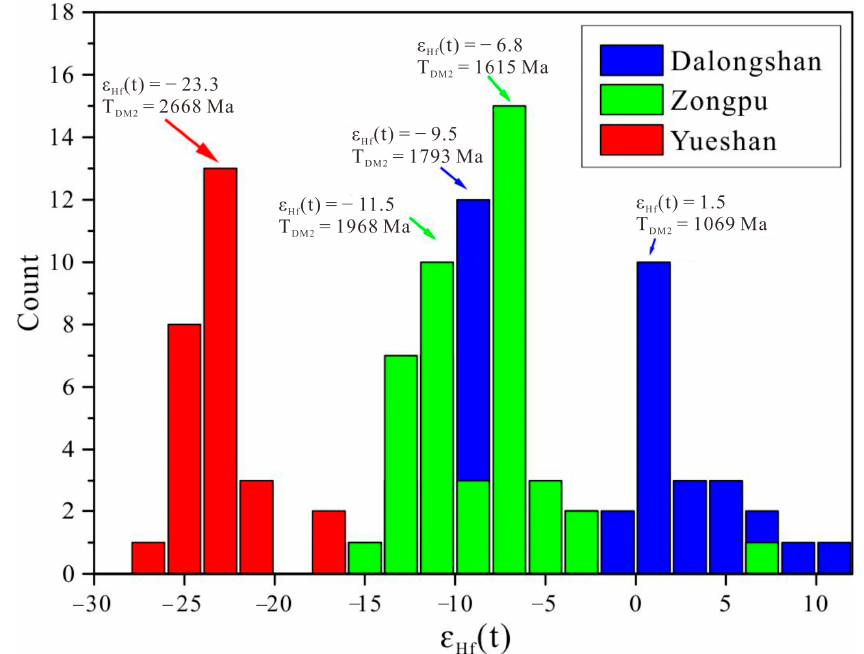
Figure 9. Frequency distribution histogram of ε Hf (t) values of zircons from granitoids in the Anqing orefield.